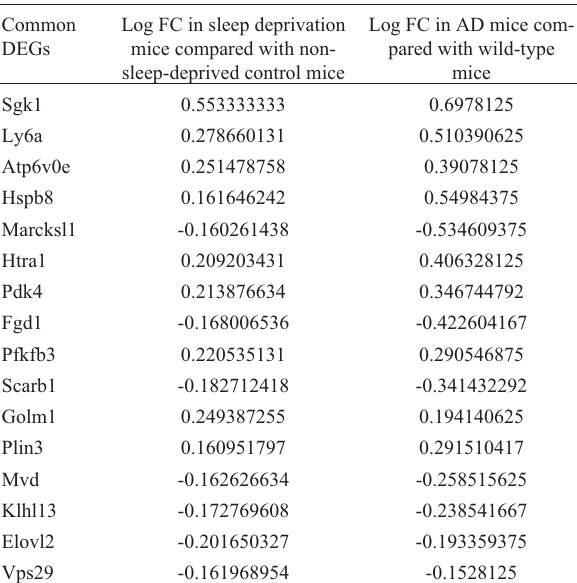
Figure 3 - Top 20 significantly enriched GO biological